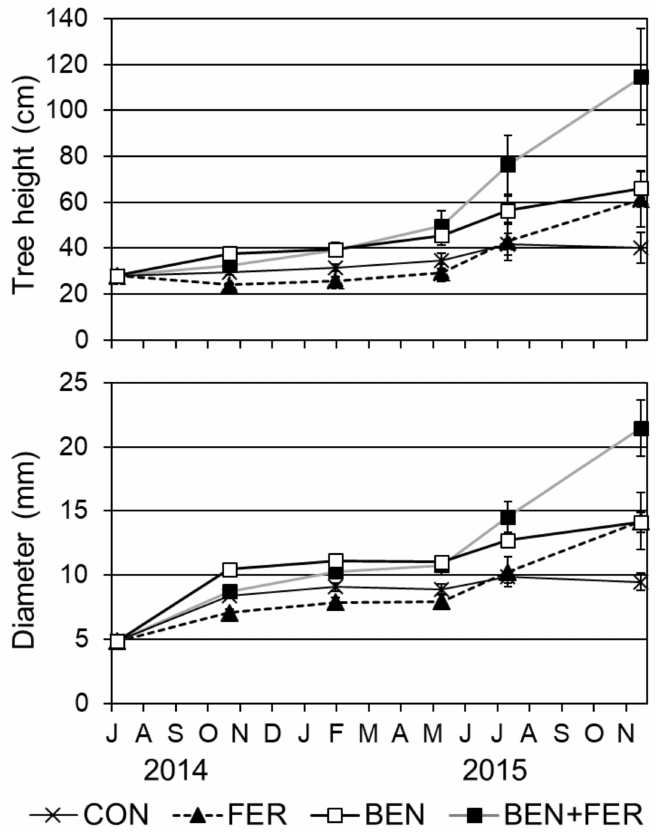
Figure 2. Tree height and basal diameter of teak seedlings grown in the four treatments (mean ± SE, n = 60). Table 3. Statistical analysis for tree height, diameter, photosynthetic rate at light saturation ( P sat ), stomatal conductance (gs), and concentration of chlorophyll ( a + b ) in teak seedlings by two-factor ANOVA. Asterisks indicate significant differences. * = p < 0.05, ** = p < 0.01 and *** = p < 0.001. Parameter Tree